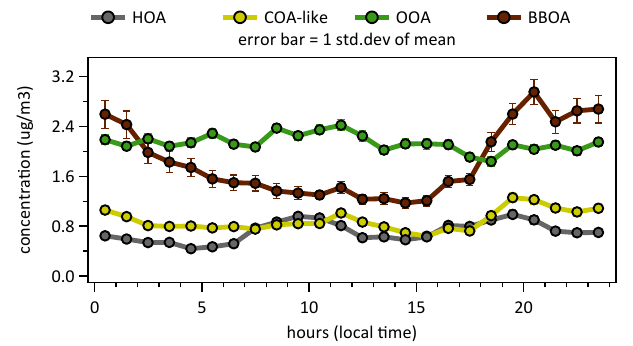
Figure 4. Diurnal variation (local time) of absolute factor concen- trations in µgm − 3 (CE=0.5, RIE org = 1 . 4). Grey: HOA, yellow: COA-like, green: OOA, brown: BBOA. The error bars represent the first standard deviation (SD). In some cases (e.g. HOA) the error bars are not visible because they are smaller than the marker